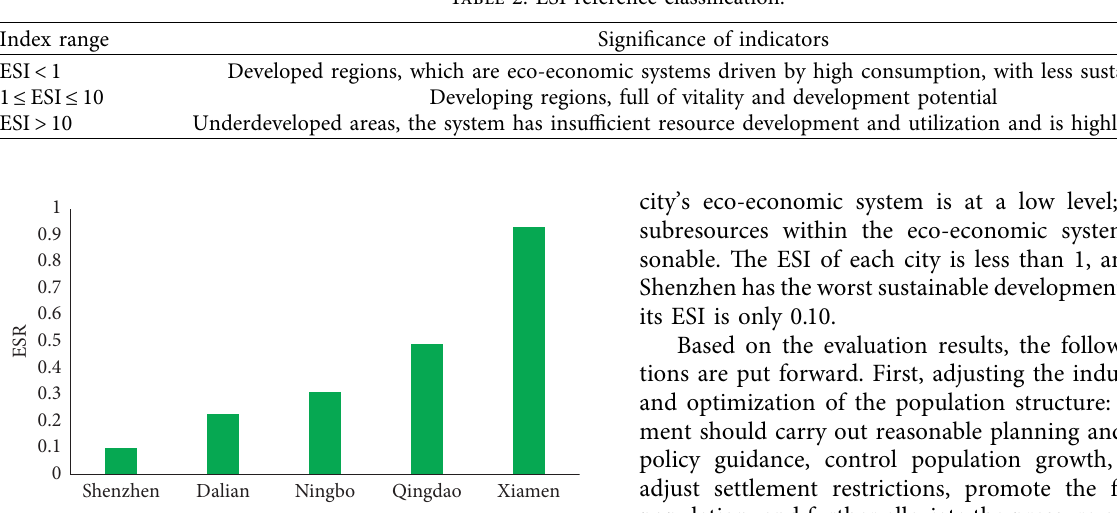
Table 2: ESI reference classification.